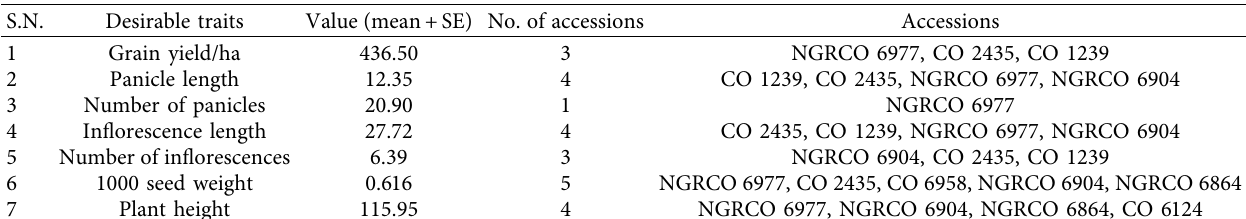
Table 6: Elite accessions for diferent yield attributing traits among 12 amaranth accessions.